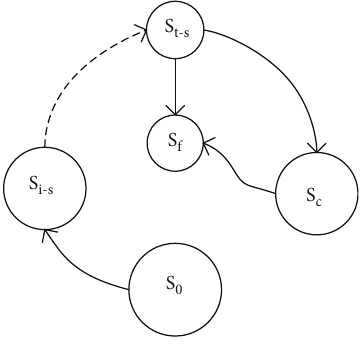
Figure 4: State transition